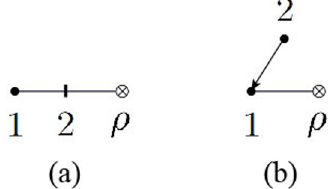
Figure 2 . Type-A graphs with two on-shell nodes.